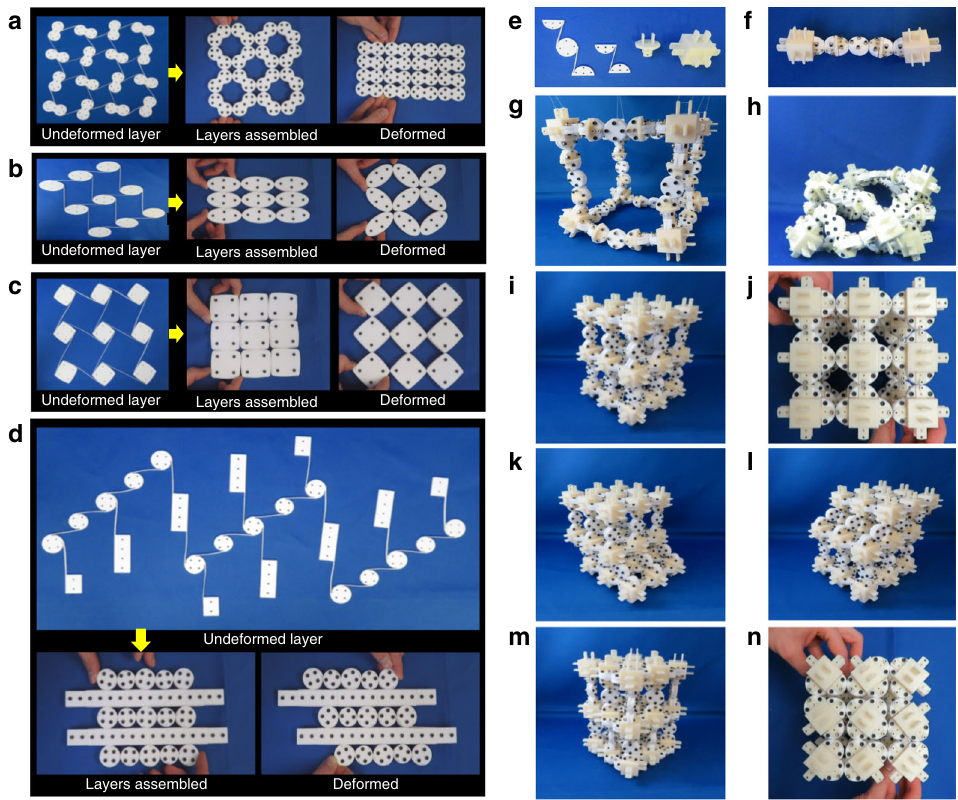
Fig. 3 Other varieties of compliant rolling-contact architected materials (CRAMs). Shape morphing can be achieved using a peanut-shaped cams, b elliptical cams, and c square-shaped cams. d Shearing motions can be achieved by combining rectangular and circular cams. e Example parts can be fabricated to assemble f strings of CRJs that can be used to enable three-dimensional (3D) CRAMs. g A cube-shaped polyhedron of these strings could h tangle into many shapes. i , j Another 3D design that can k , l shear in tangential directions and exhibit m , n an auxetic behavior that stiffens those